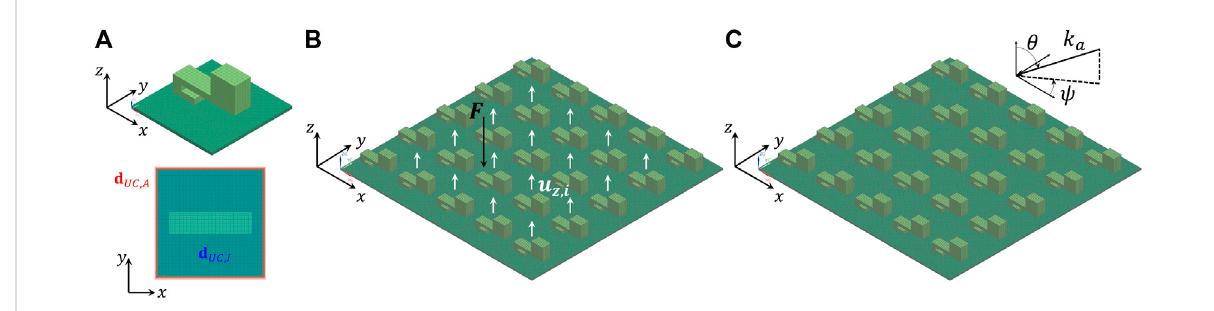
FIGURE 1 (A) LRMUCFEmodel(top)withhighlightedinterior( d UC , I )andboundary( d UC , A )DOFs(bottom), (B) fi niteLRMplateassemblycomposedof5×5 UCs with input point force and output displacement locations and (C) with oblique acoustic plane wave